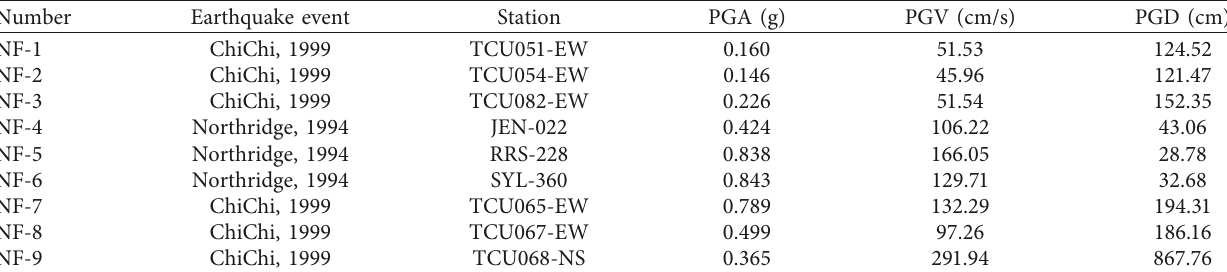
Table 3: Records of near-fault ground